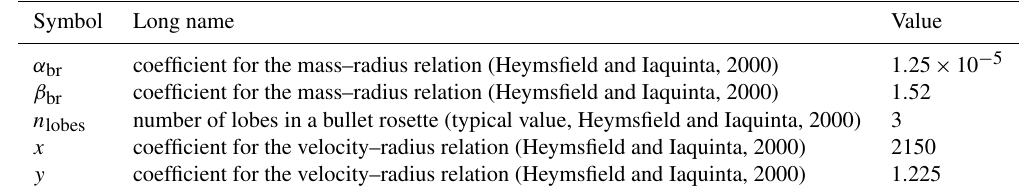
Table A6. Same as Table 2 but for bullet rosettes. Only those constants that differ from Table 2 are shown.